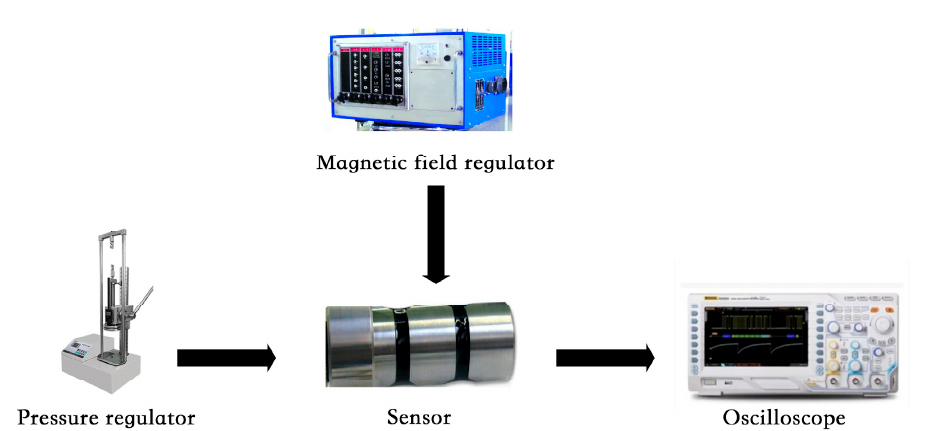
Figure 13. Sensor test platform.